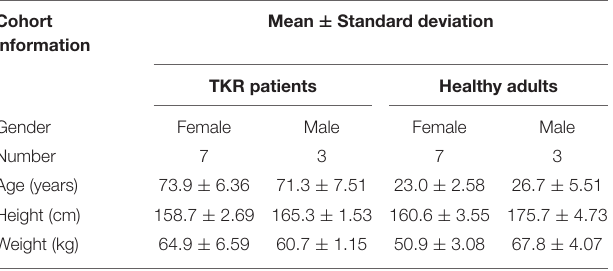
TABLE 1 | Demographic characteristics of TKR patients and healthy